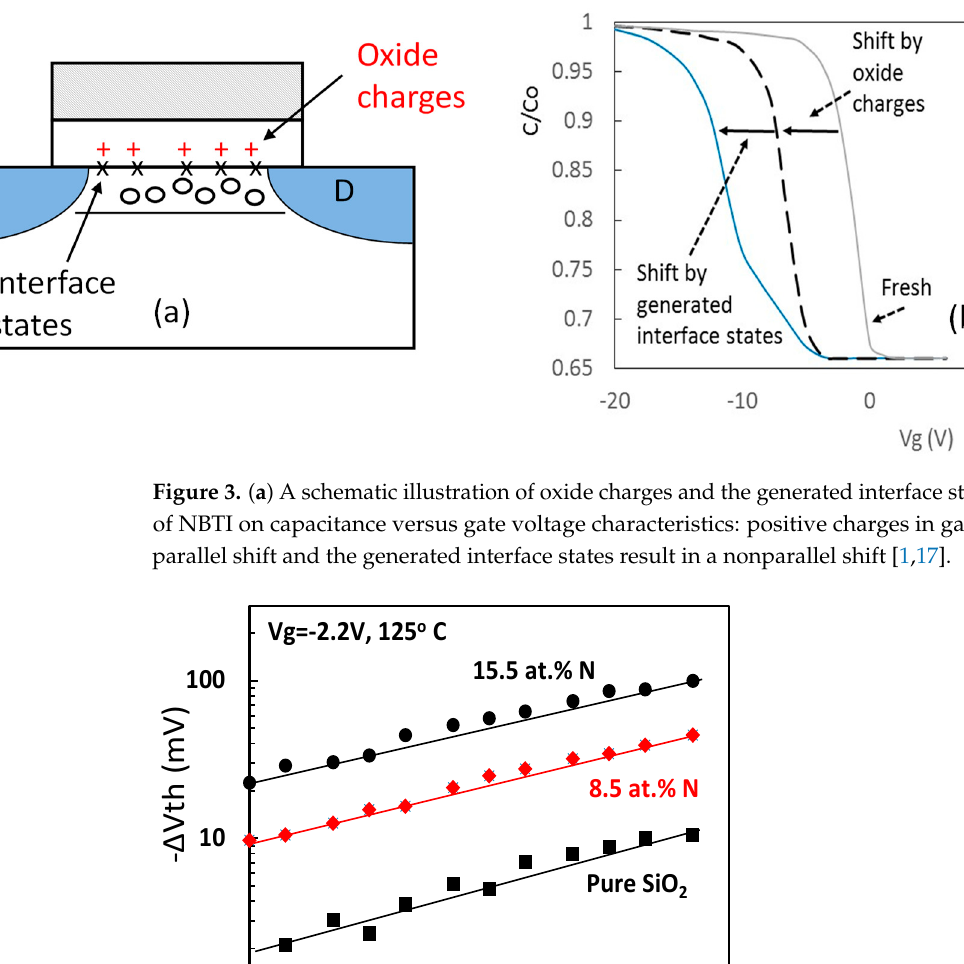
Figure 3. ( a ) A schematic illustration of oxide charges and the generated interface states; ( b ) the effect of NBTI on capacitance versus gate voltage characteristics: positive charges in gate oxide lead to a parallel shift and the generated interface states result in a nonparallel shift [1,17].